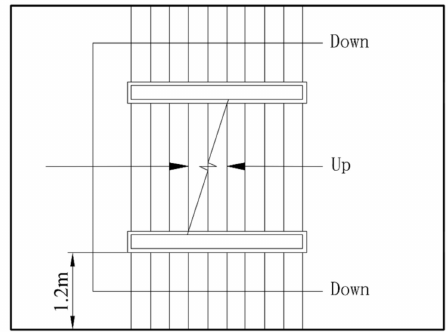
Figure 3. The double-divided staircase.